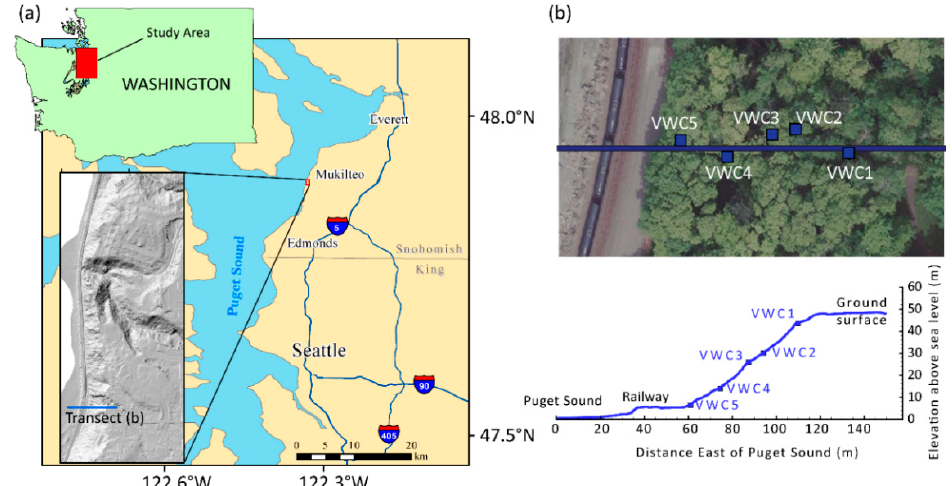
Figure 2. ( a ) Map of the monitoring location along the Seattle-Everett railway in Mukilteo, Washington, USA. Inset lidar image shows hillslope transect location (in blue); ( b ) Hillslope transect with five VWC instrument locations and depths and aerial image of the field site. Adapted from Mirus et al., 2016 [29].